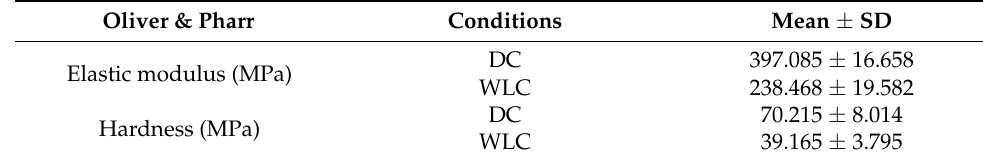
Figure 5 summarized the results of the friction test performed at the speeds of 1 mm/s, 3 mm/s, and 5 mm/s under DC and WLC. The COF increased from sandpaper size of